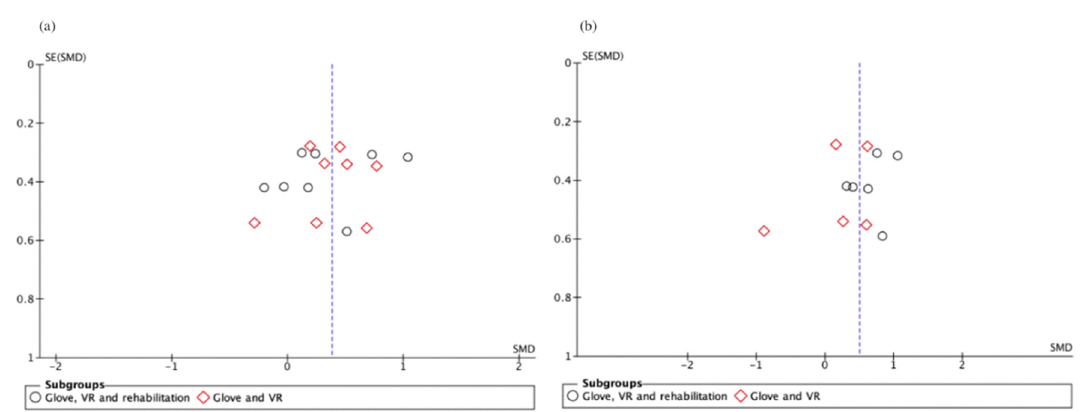
Figure A1. Funnel plot of short-term ( a ) and long-term ( b ) upper limb functionality studies. Slight asymmetry, meaning possible publication bias.